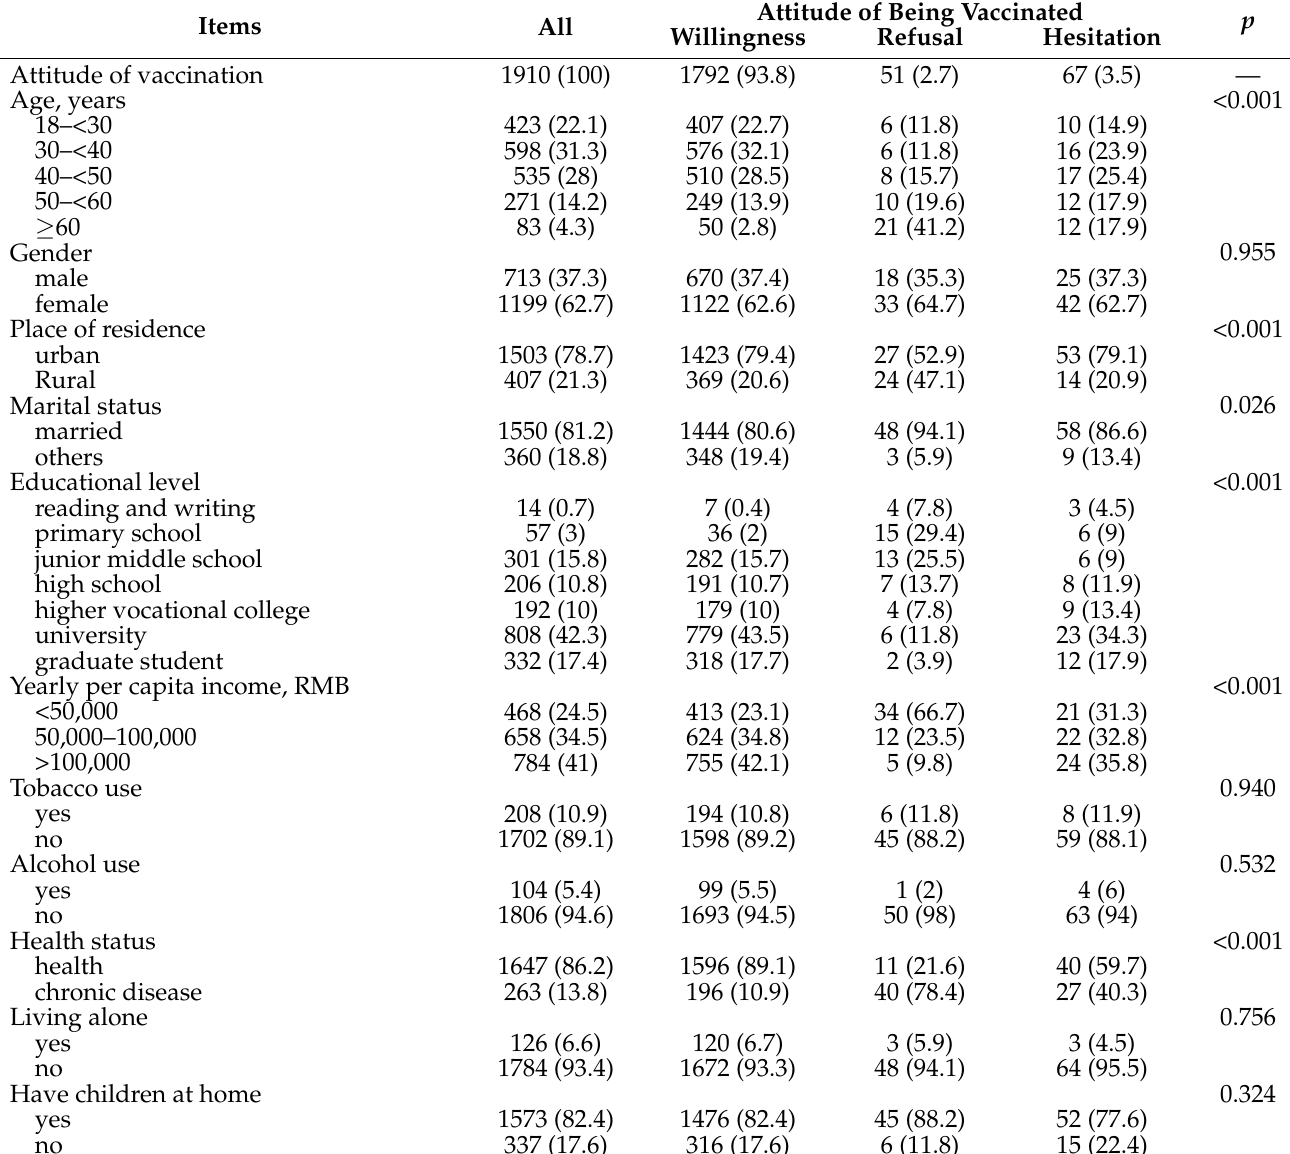
Table 2. The differences between willing, unwilling, and hesitant attitudes in relation to knowledge of COVID-19. Items